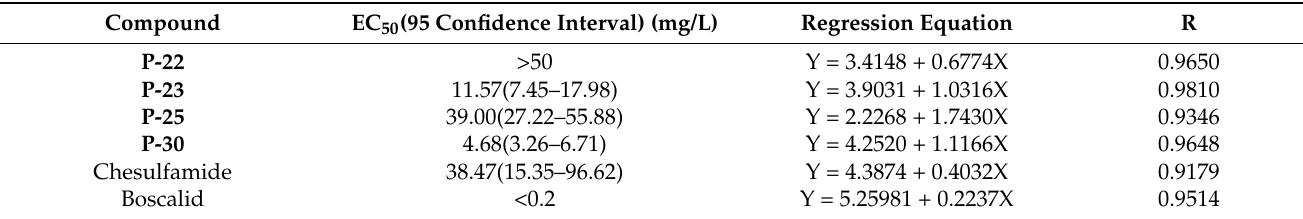
Table 2. EC 50 of compounds against Botrytis cinerea .